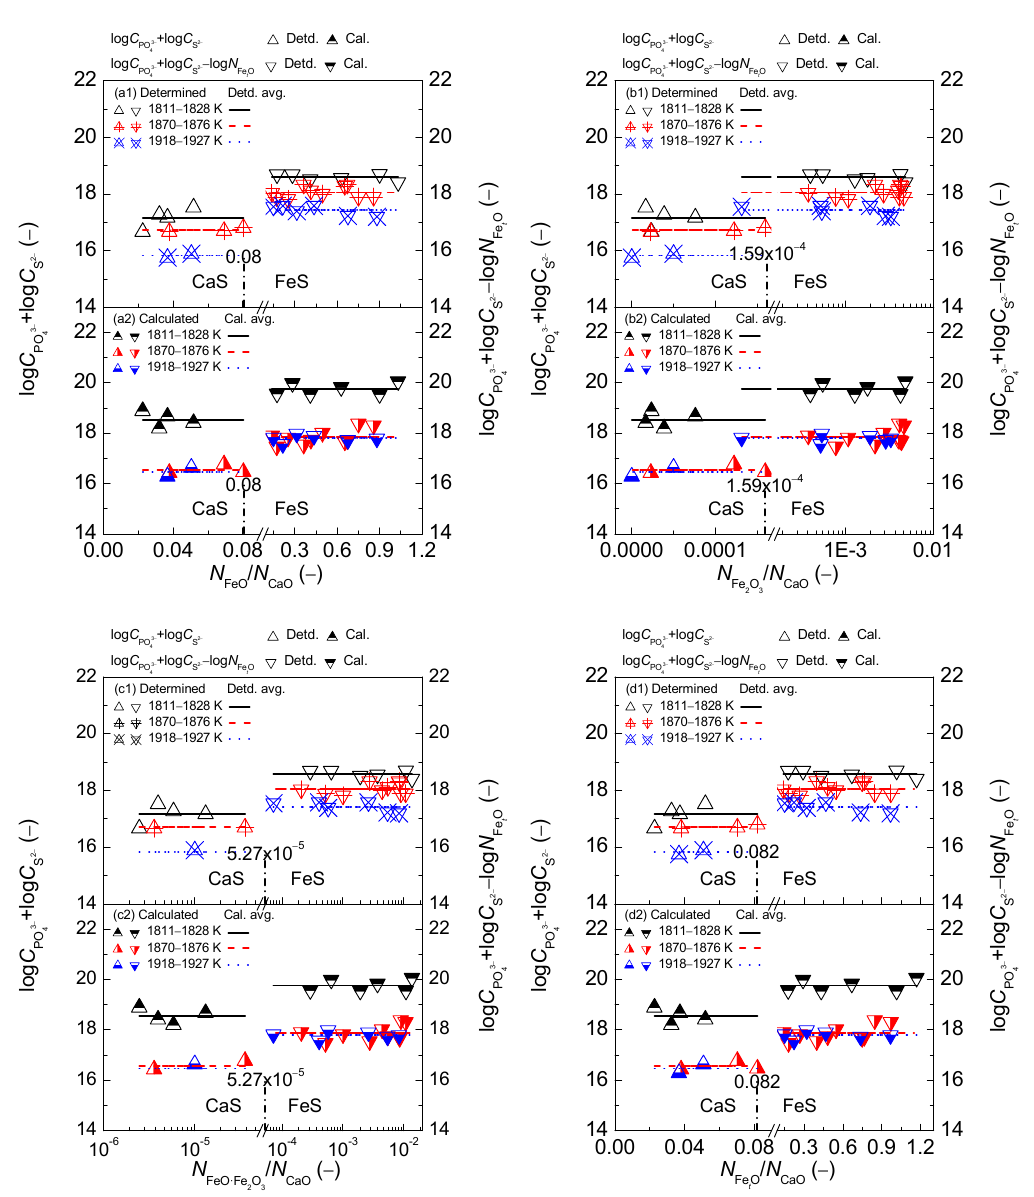
Figure 13. Relationship of the mass action concentration ratio N FeO / N CaO ( a ) or N Fe / N CaO 2 O 3 Figure 13 . Relationship of the mass action concentration ratio + ( b ) or N FeO · Fe / N CaO ( d ) against the determined term log C / N CaO ( c ) or N Fe t O 2 O 3 PO 3 − 4 , determined against the determined term + log C − log N log C or log C FeO after Ban-ya et al. [1] S 2 − , determined S 2 − , determined PO 3 − 4 , determined after Ban-ya et al. based on results from Yang et al. [3,5] in the second layer to 1927 K (1538 to 1654 °C), respectively.